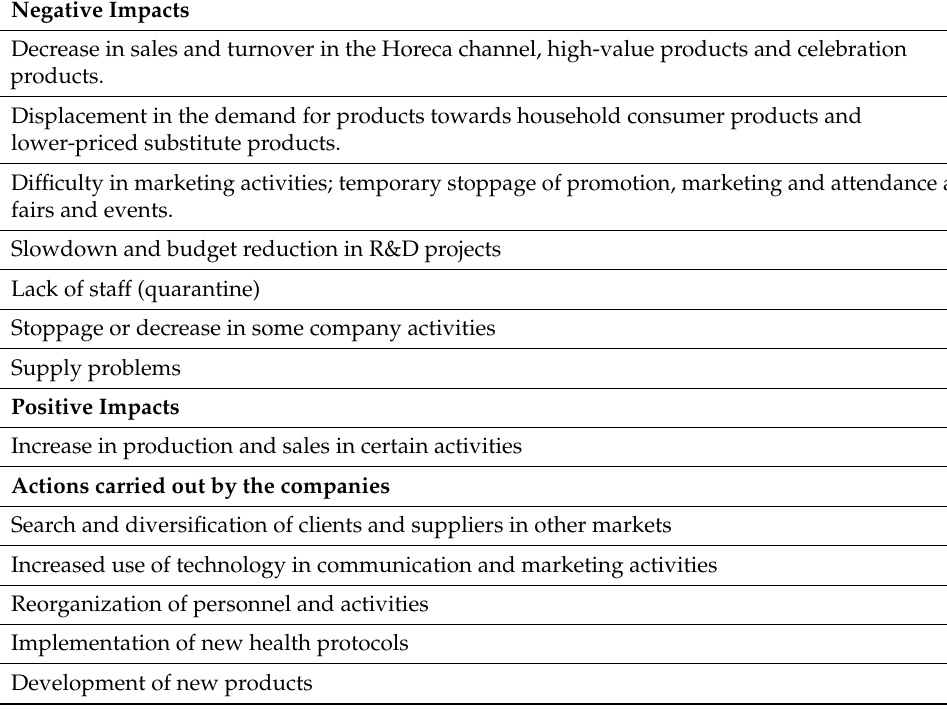
Table A4. Summary of the results. Negative Impacts Decrease in sales and turnover in the Horeca channel, high-value products and celebration